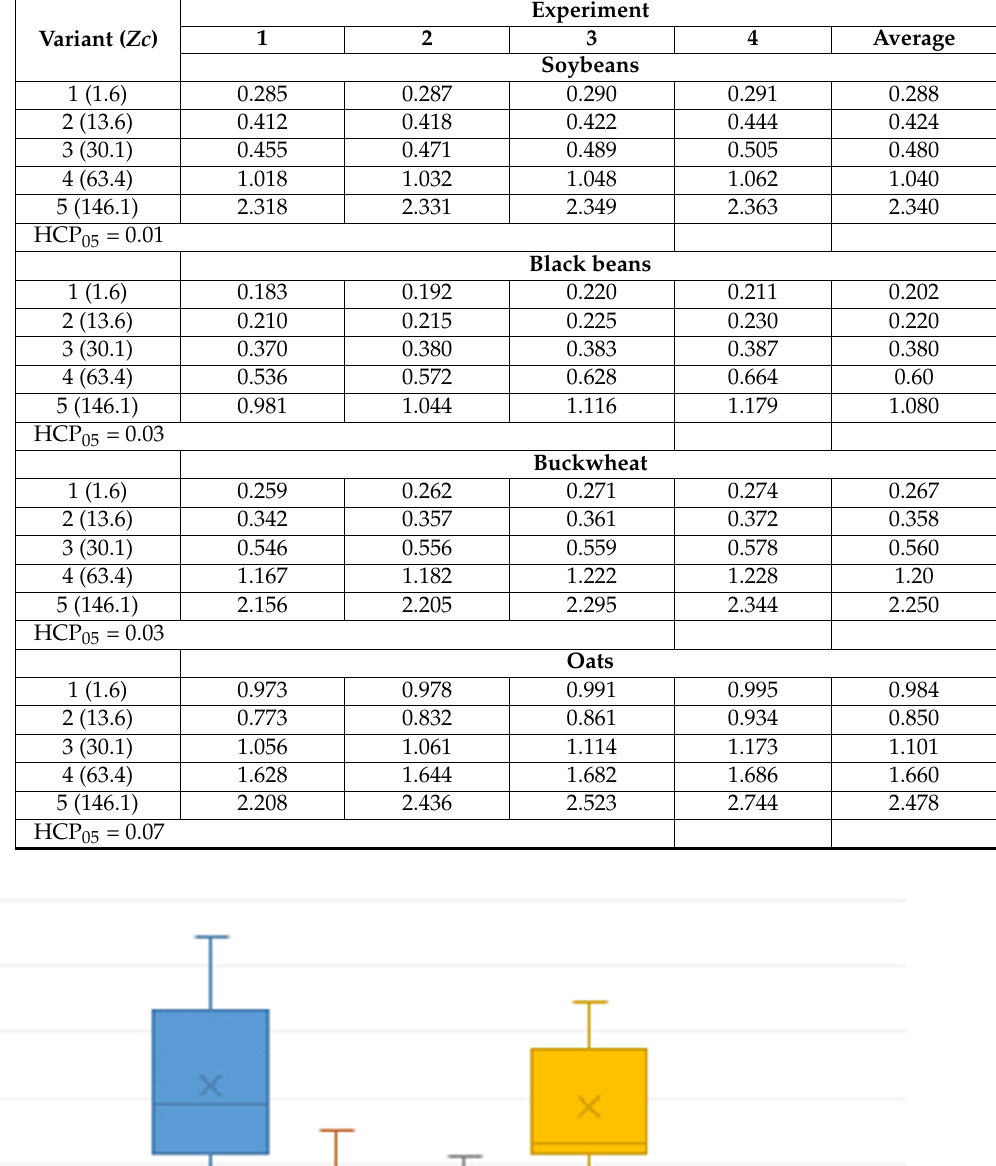
Table 5. Cadmium content in the phytomass of test crops, mg/kg.